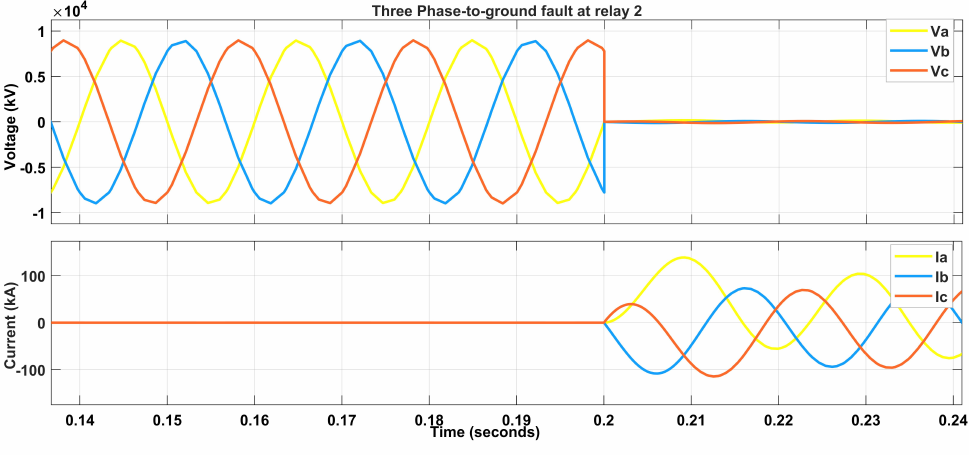
Figure 8. Three phases to ground fault at relay